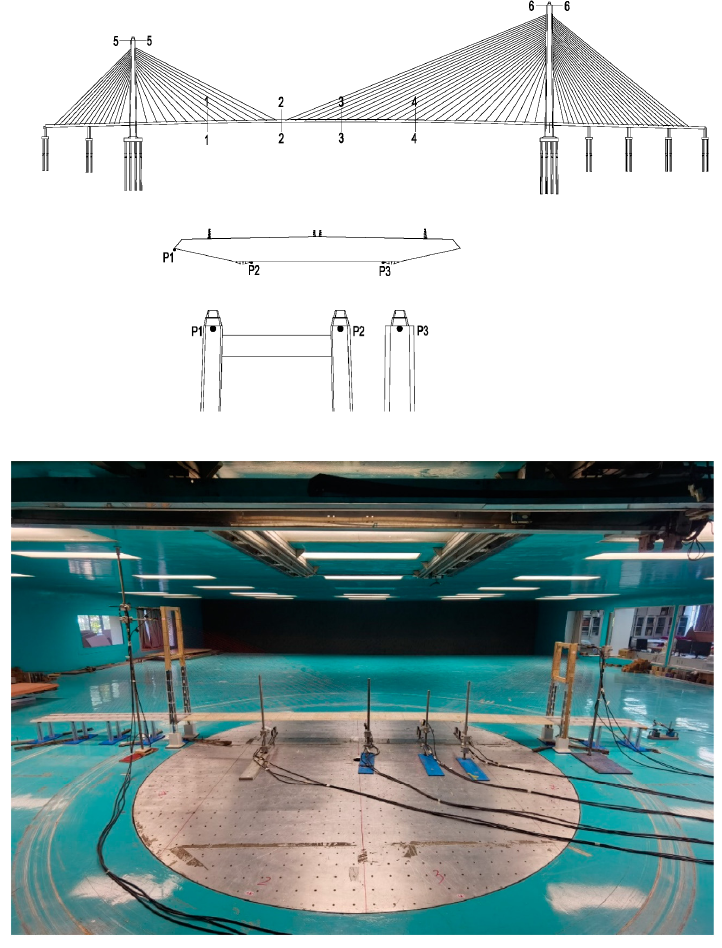
Figure 17. Measurement point